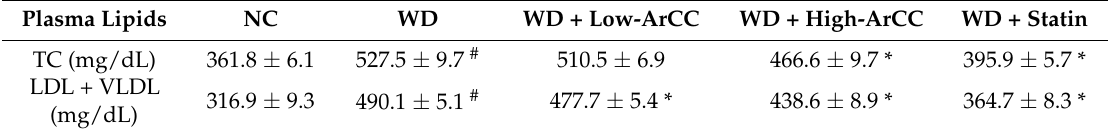
Table 2. Plasma lipids in ApoE − / − mice after 12 weeks of ArCC